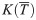
HPV infection.(a) Infected basal cells Y1 (blue solid line) and suprabasal, transit-amplifying cells, Y2 (red dashed line); (b) HPV W (green solid line) and CTL E (purple dashed line) for ε = 0.5 per day and K(T¯) = 35 cells. All the other parameters are listed in Table 1.